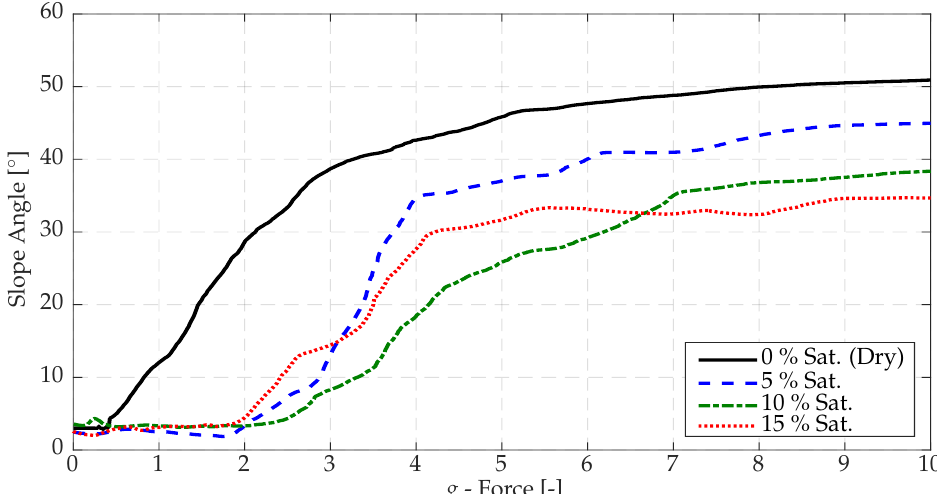
Figure 22. The slope of the fine sand as measured in the centrifuge test for various moisture contents and as a function of the lateral acceleration